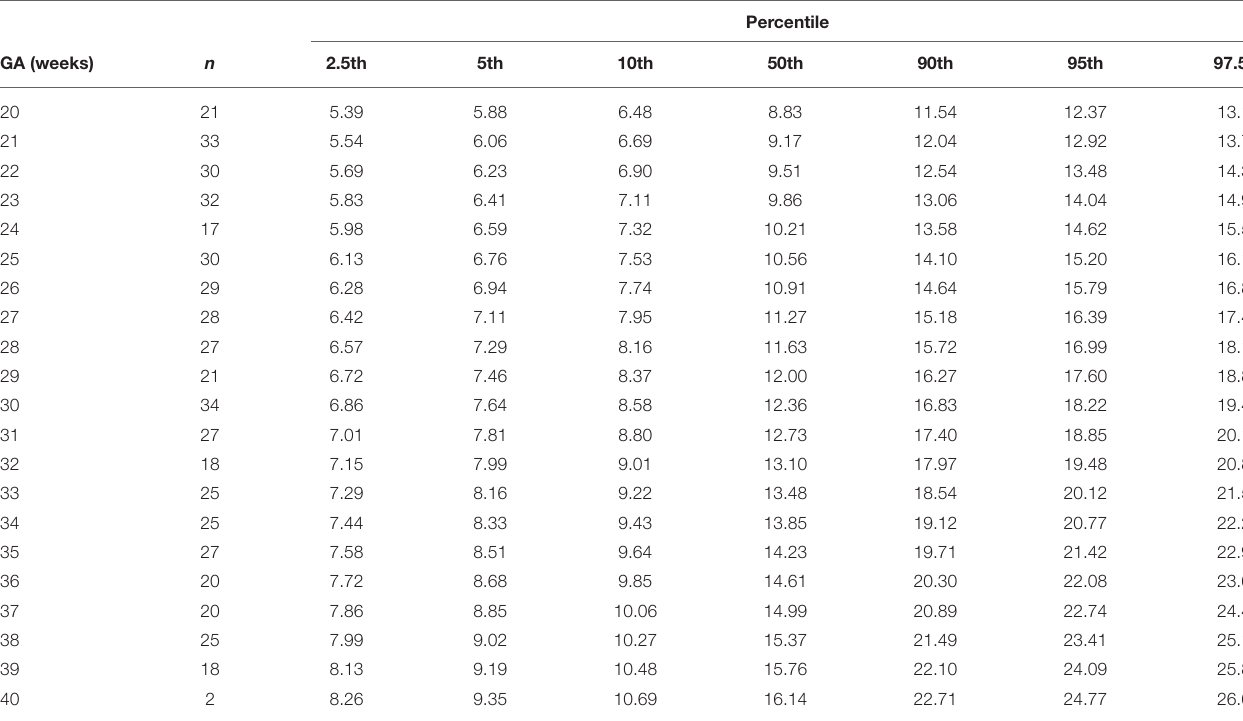
TABLE 1 | Percentiles of fetal superior vena cava mean blood velocity (cm/s) at 20–40 weeks of gestational age (GA).